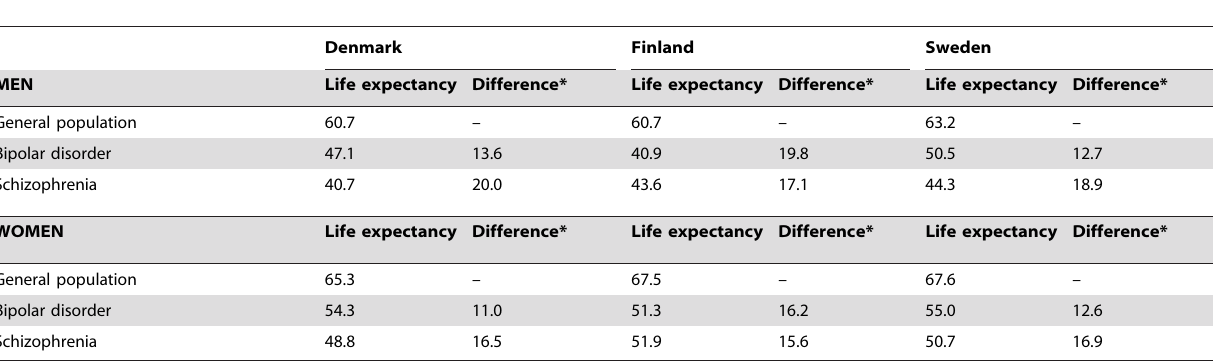
Table 3. Remaining life expectancy at age15 and difference in life expectancy compared to general population among patients with bipolar disorder and schizophrenia in Denmark, Finland, and